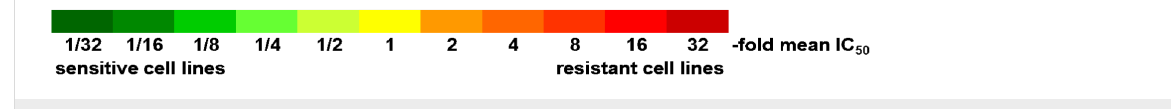
Figure 13: Individual IC 50 values [µM] of compounds 1 , 3 – 7 in a panel of 11 human tumor cell